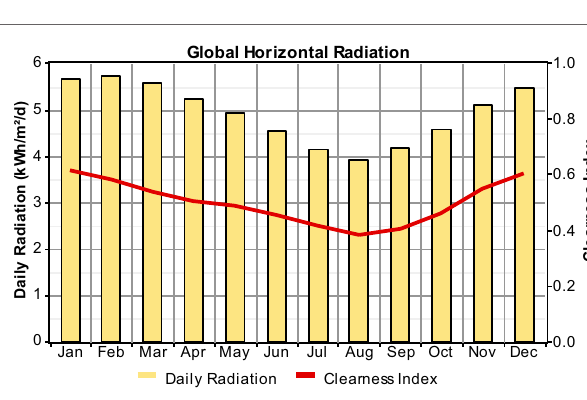
FigUre 3 | graphics of monthly solar radiation profile for nsukka .